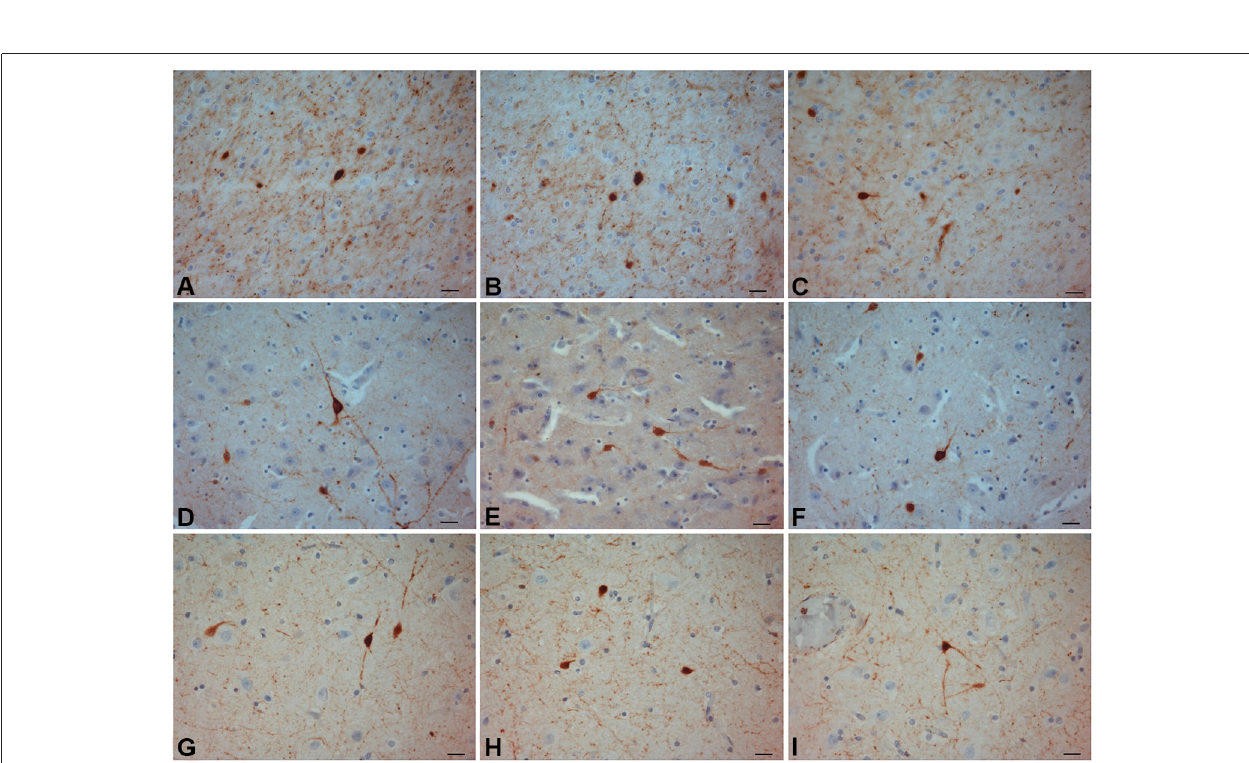
FIGURE 2 | CR-ir neurons . (A–C) crab-eating monkey; (D–F) chimpanzee; (G–I) human. Scale bars = 20 µ m.